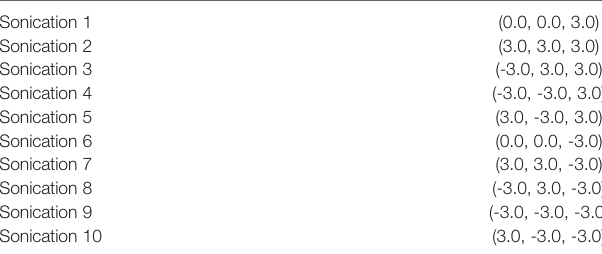
TABLE 3 | The table shows the steering used for all sonication; coordinates are listed in mm.